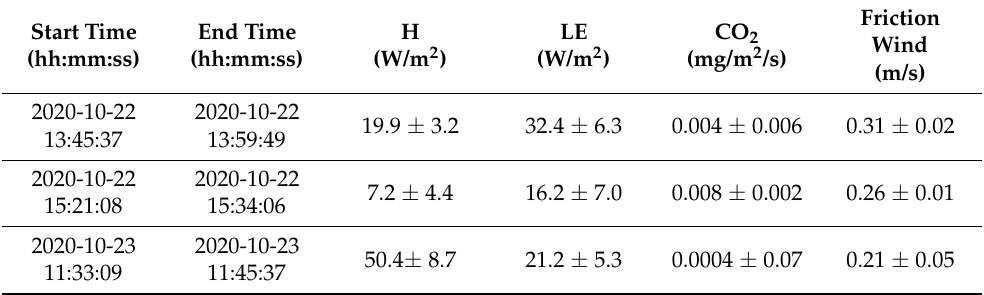
Table 4. Summary of the flux calculation results of the UAV from the in-flight comparison